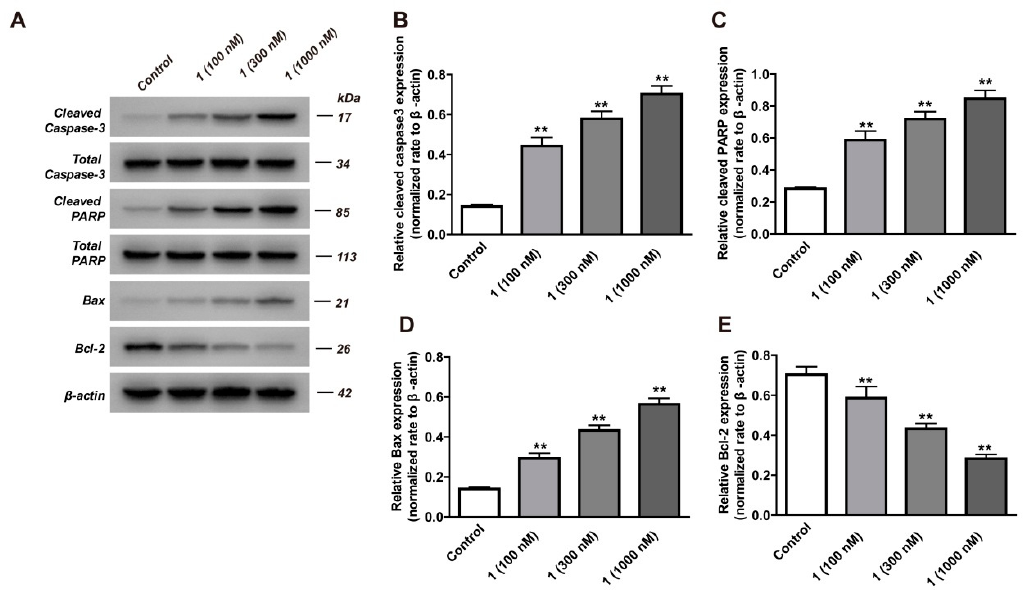
Figure 4. The e ff ects of compound 1 on cleaved caspase-3, caspase-3, cleaved PARP, total PARP, Bax, Bcl-2 expressions in HepG2 cells. HepG2 cells were cultured in the presence or absence of compound 1 (100, 300, 1000 nM) for 24 h. ( A ) The expressions of cleaved caspase-3, caspase-3, cleaved PARP, total PARP, Bax and Bcl-2 were measured by Western blot assay, with β -actin serving as a loading control. ( B – E ) The relative expressions of cleaved caspase-3, caspase-3, cleaved PARP, total PARP, Bax and Bcl-2 were normalized to β -actin. Results are shown as mean ± SD for the three individual experiments which, for each condition, were performed in triplicate. Compared with the control group, ** p <